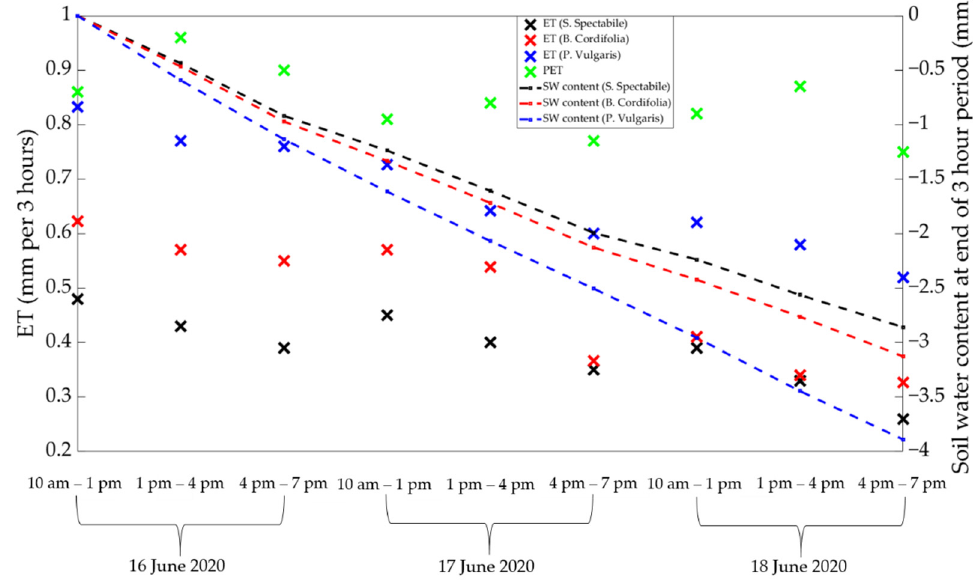
Figure 8. Calculated PET , measurements of ET (via mass loss method, for each plant) and soil water content decrease, SW, (for each plant) between 16–18 June 2020.